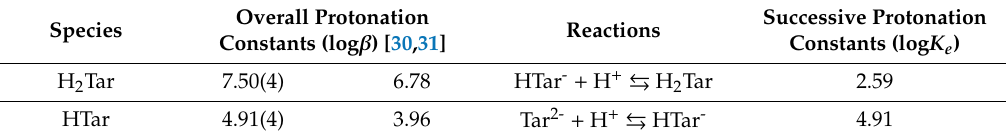
Table 1. Protonation constants of tartaric acid (standard deviation are given in